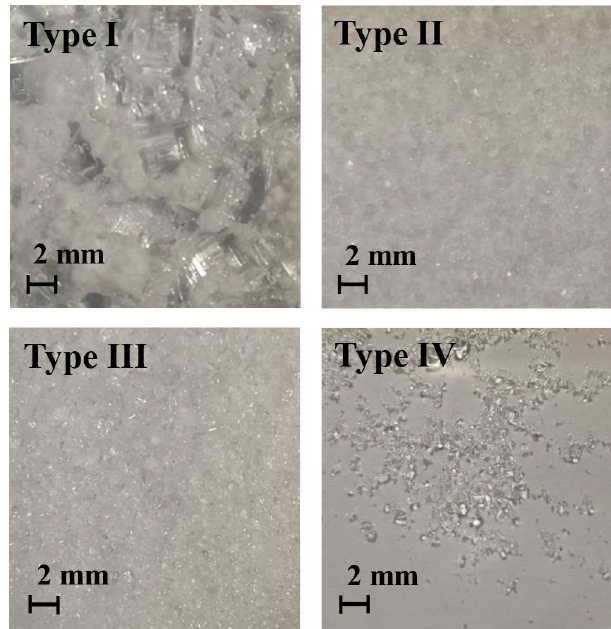
Figure 5. Characteristic morphologies of coated KI (top view) ob- served by a mobile phone camera. Type I: KI film; type II: KI grain pre-humidified in a 50% RH N 2 environment for 30min; type III: KI grain pre-humidified in a 73% RH N 2 environment for 30min; type IV: saturated KI solution with deposited KI grains which can- not be further dissolved. Note that type IV has a smooth liquid sur- face.